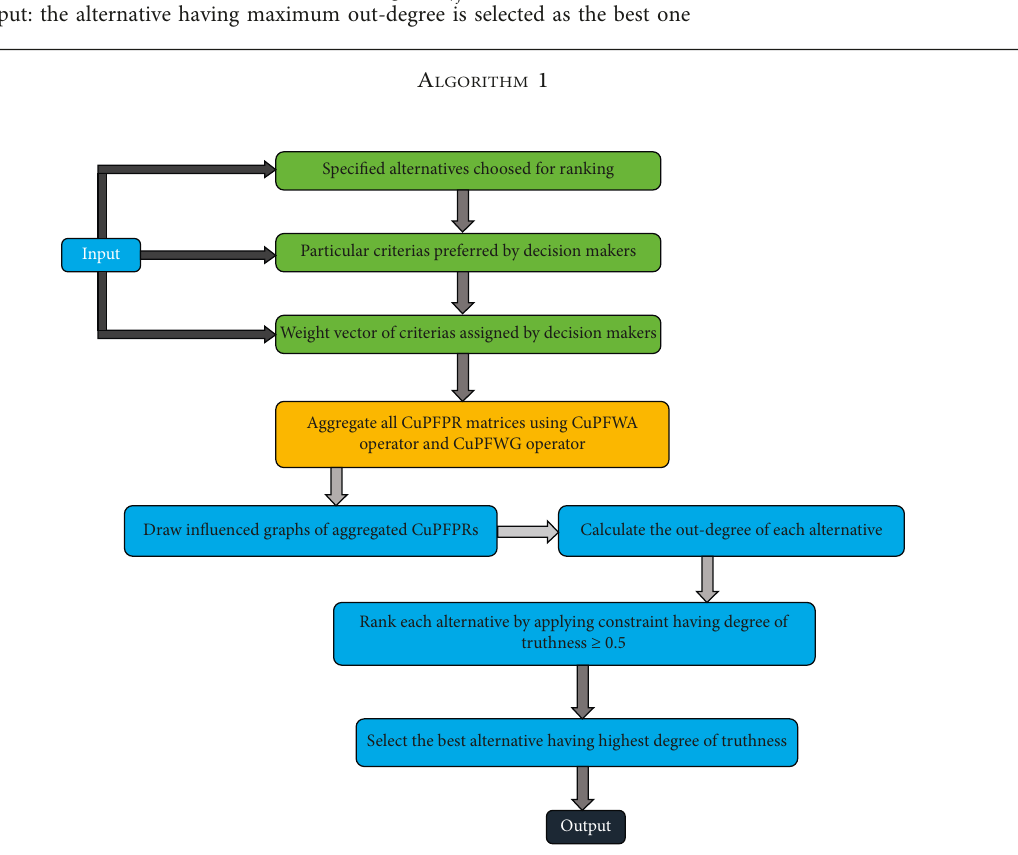
Figure 12: Flowchart of the purposed